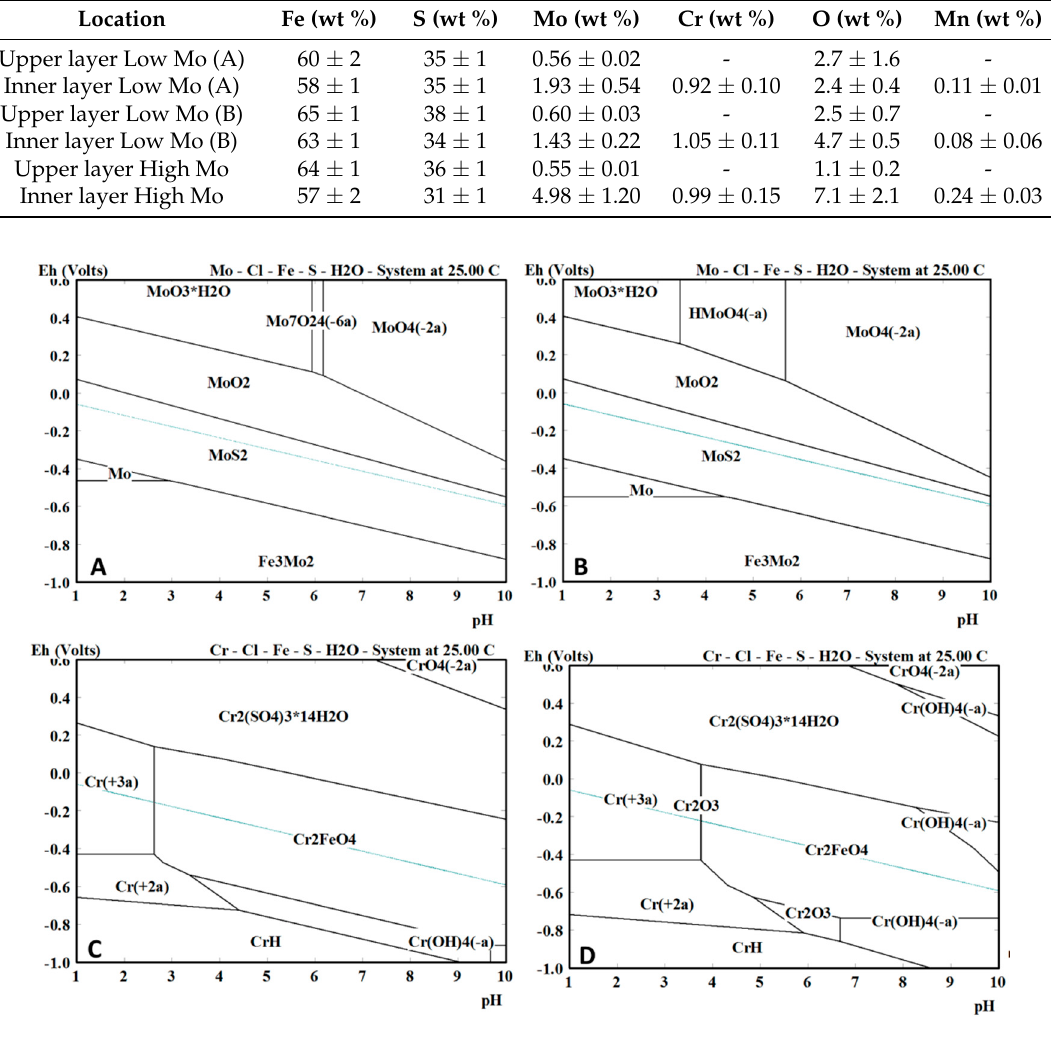
Figure 7. The equilibrium phase diagram obtained using HSC Chemistry for the Mo and Cr specimens near the surface ( A , C , respectively) and further away from the surface ( B , D , respectively). During the test a pH value between 2.8 and 4.0 was maintained.